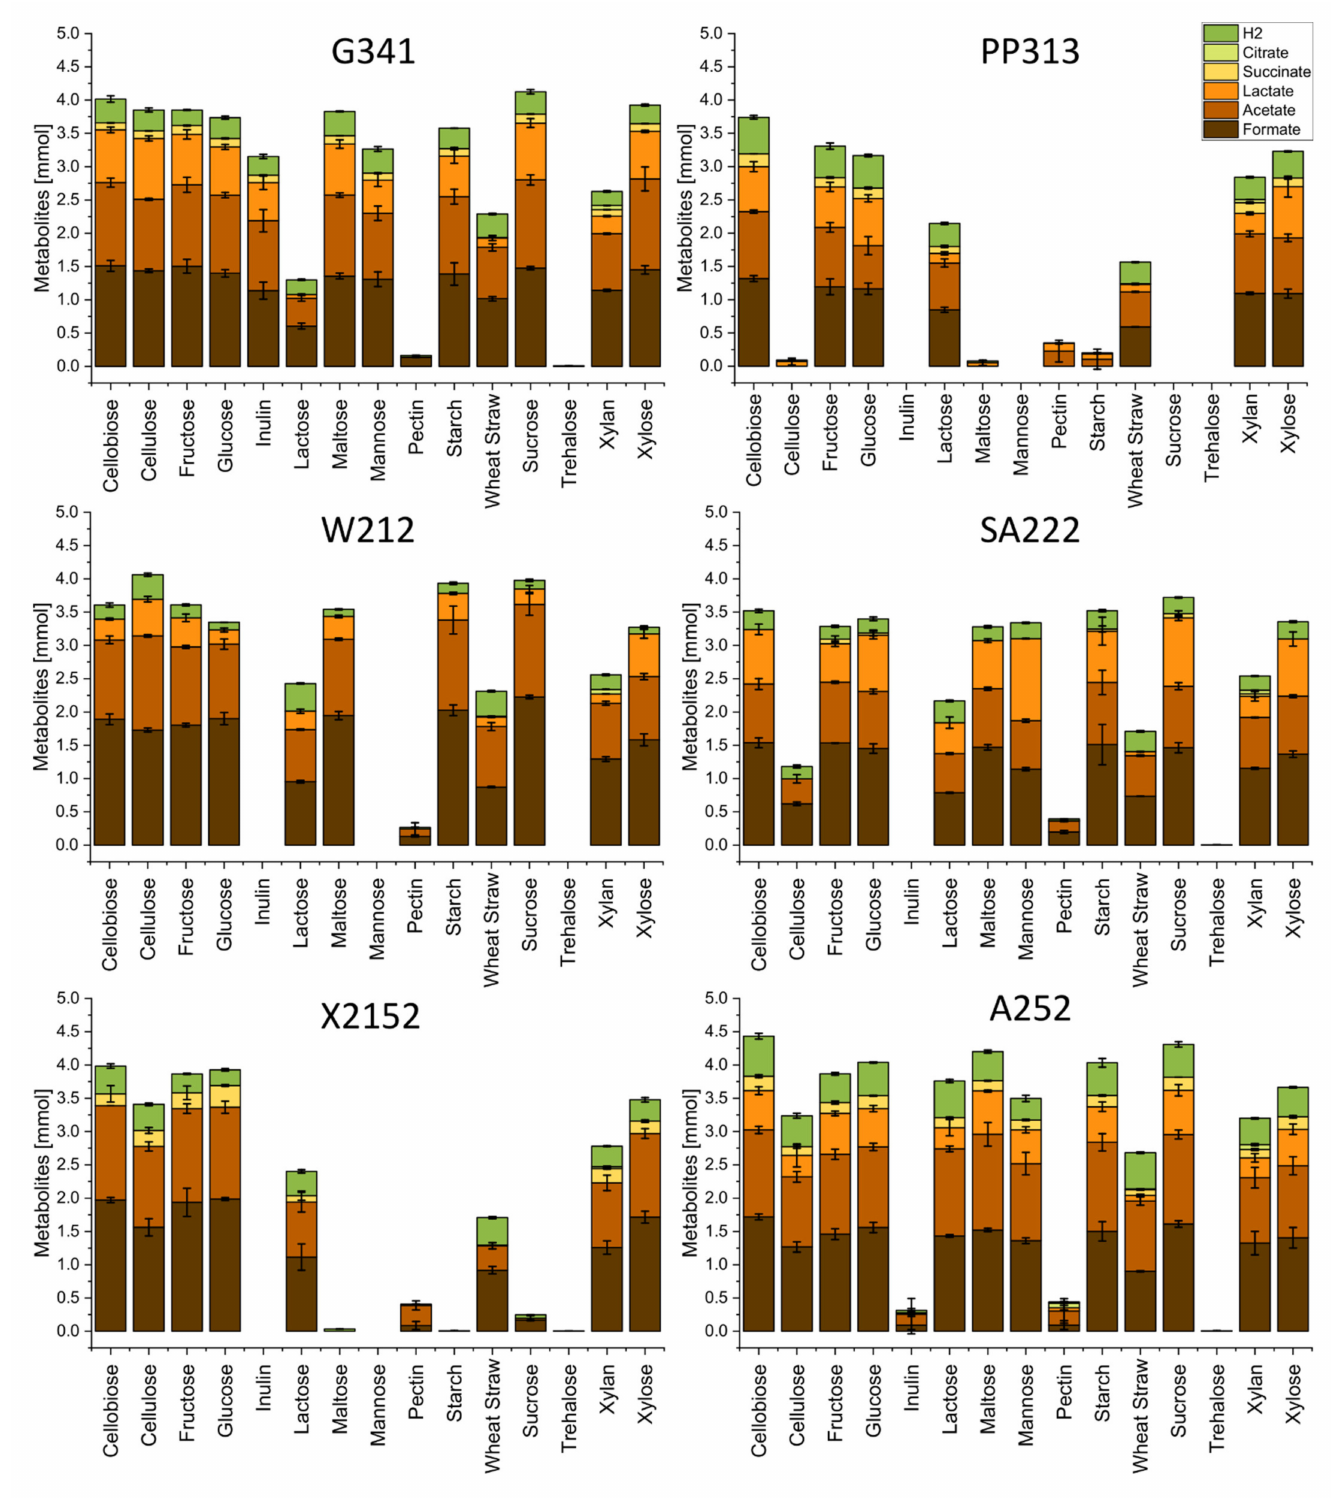
Figure 2. Produced metabolites (mmol) of the strains G341, PP313, W212, SA222, X2152 and A252 during growth on different C-sources. Ethanol is excluded. Values shown represent averages of triplicate experiments and standard